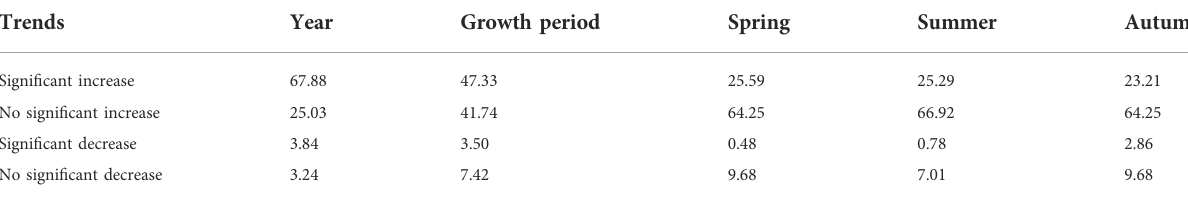
TABLE 2 Proportion of the variation trend area of NPP with different degrees on different time